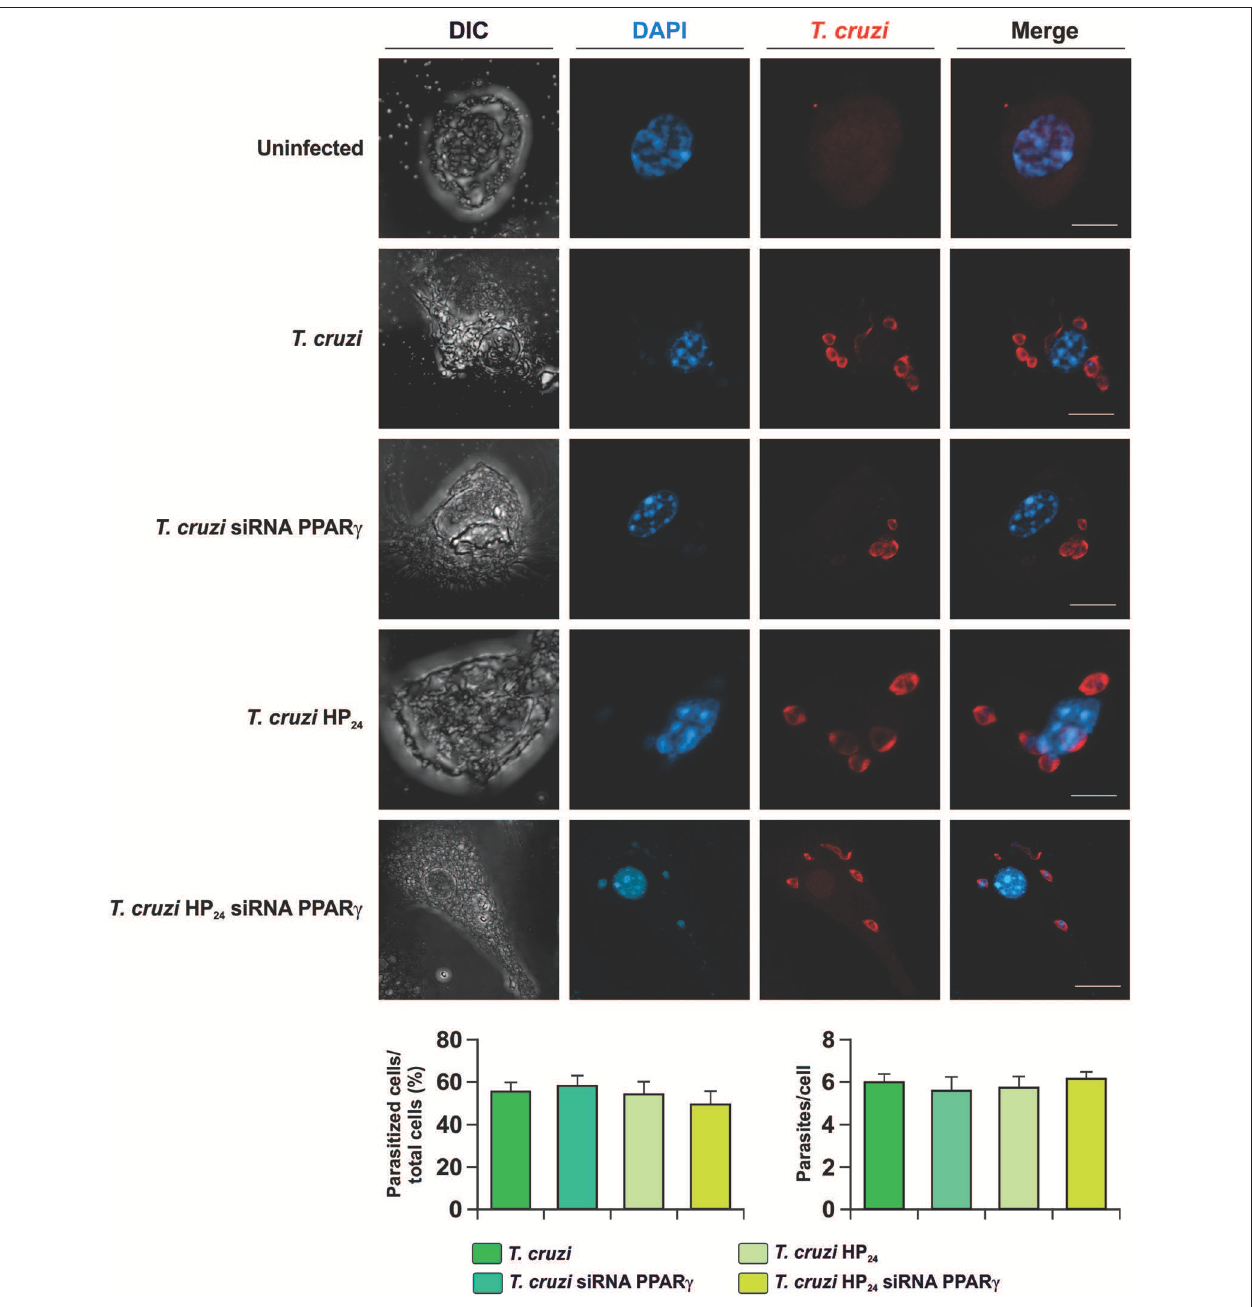
FIGURE 2 | Neither HP 24 nor PPAR γ modifies parasitism in T. cruzi -infected macrophages. Peritoneal macrophages were obtained and transfected with PPAR γ -siRNA during 72h. Transfected or non-transfected cells were treated with HP 24 (100 µ M). Then, these cells were infected with T. cruzi for 48h (parasite:cell ratio 5:1). T. cruzi was detected by confocal microscopy with a rabbit polyclonal anti- T. cruzi antibody and a secondary goat anti-rabbit Alexa 647-labeled antibody. Cell nuclei were stained with DAPI. Representative microphotographs are shown. The percentage of infected cells and the number of parasites per cell were determined by analyzing the presence of intracellular amastigotes and trypomastigotes in at least 30 random microscopic fields. Scale bar: 5 µ m. Results represent the mean ± SEM of three independent experiments.